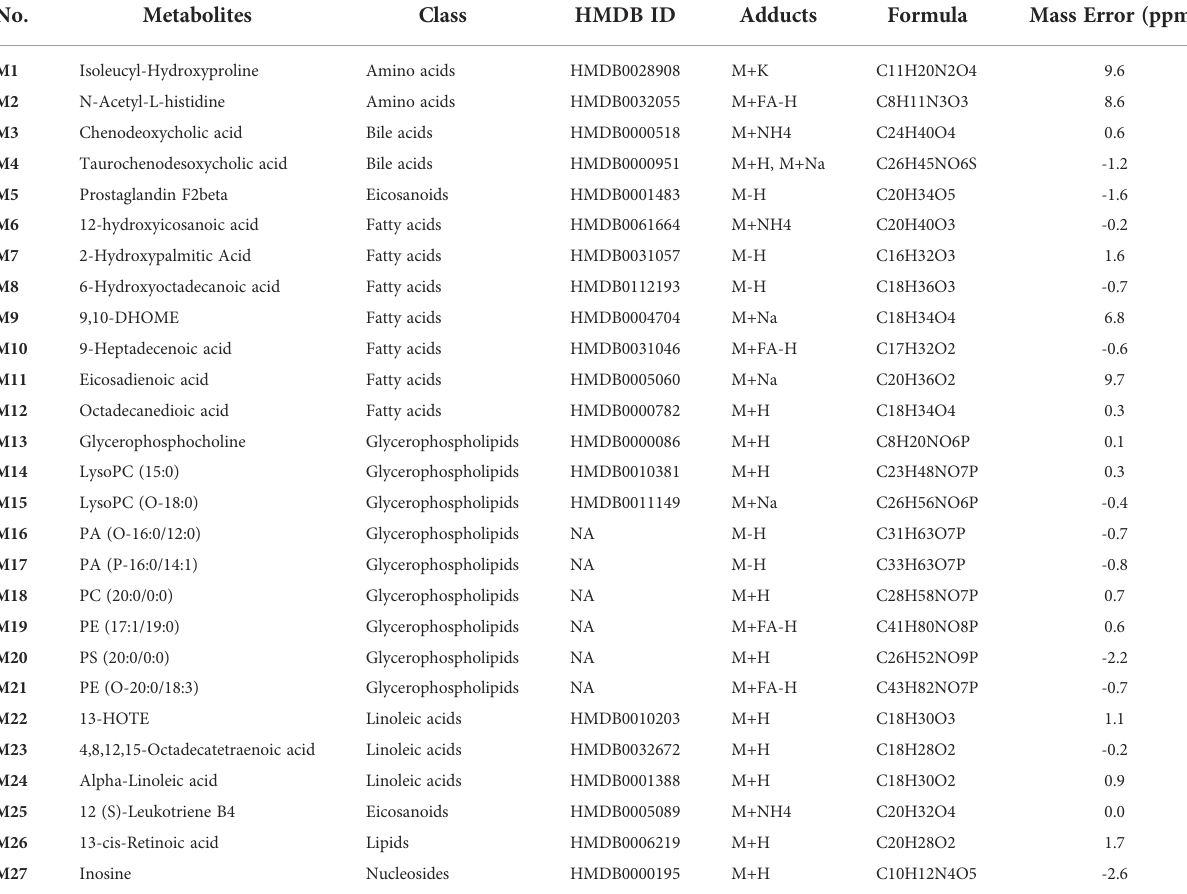
TABLE 1 Differential metabolites signi fi cantly associated with immune-in fl ammatory indicators in the serum metabolome.